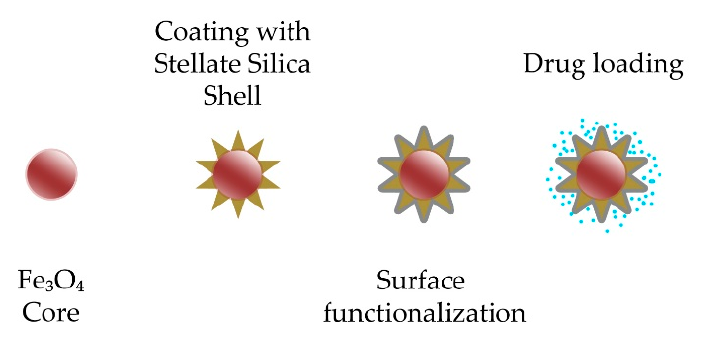
Figure 9. Core-shell nanoparticles for combined drug delivery and hyperthermia applications.